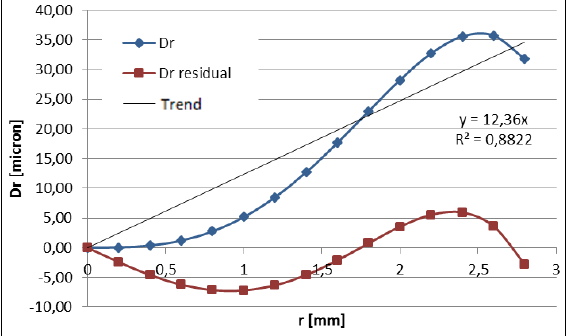
Figure 6 - Acceleration residuals for Samsung S4